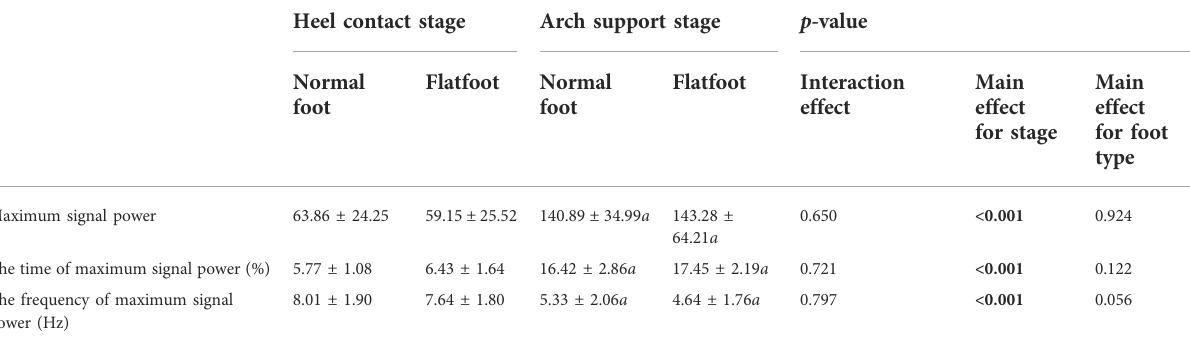
TABLE 3 Statistical results of plantar impact force in time-frequency